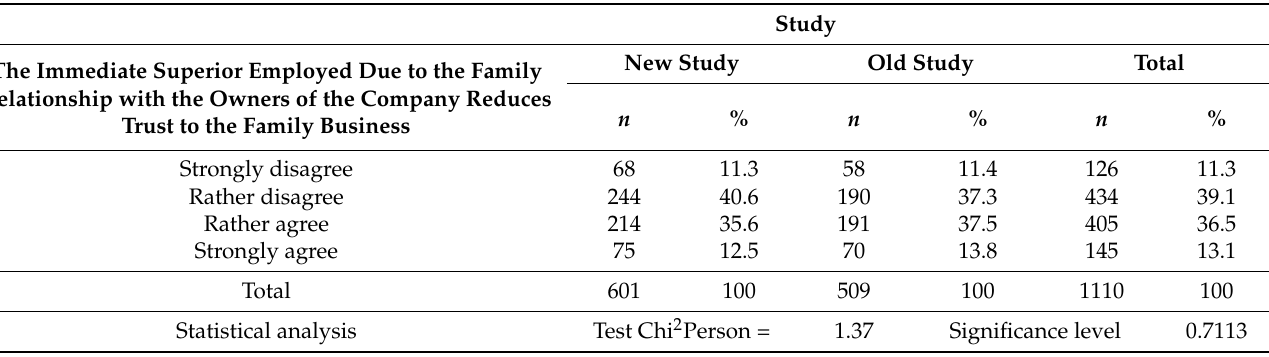
Table 16. Statistical analysis of the assessment of the impact of the employee’s immediate superior due to the relationship with the owners of the company on trust in the family business depending on the date of the study.